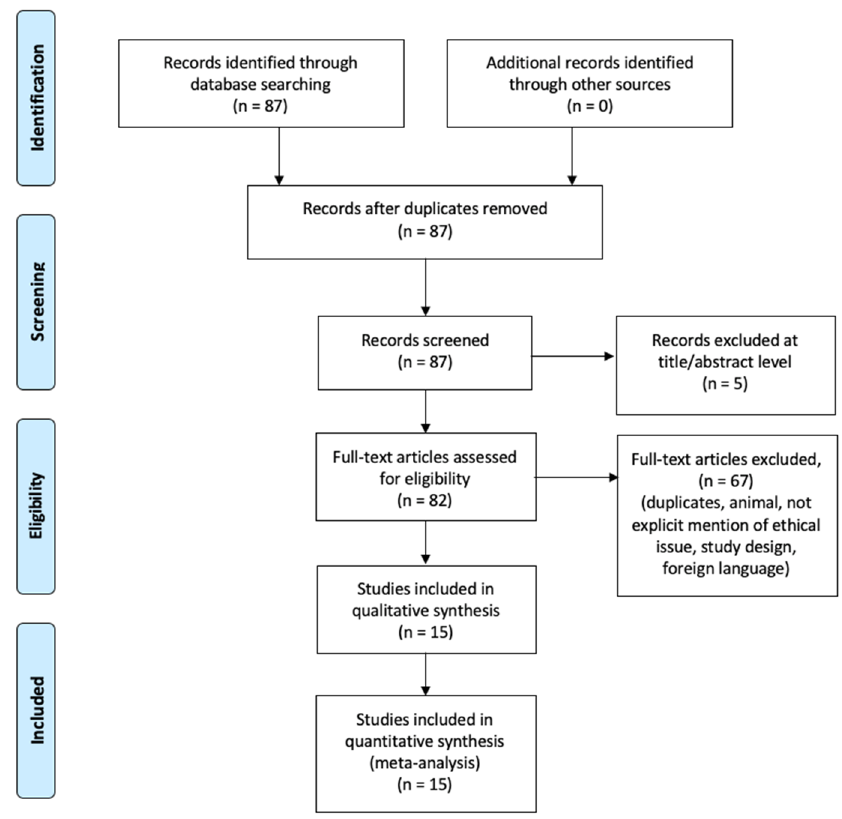
Figure 1. Preferred Reporting Items for Systematic Review (PRISMA) flow chart—search strategy.